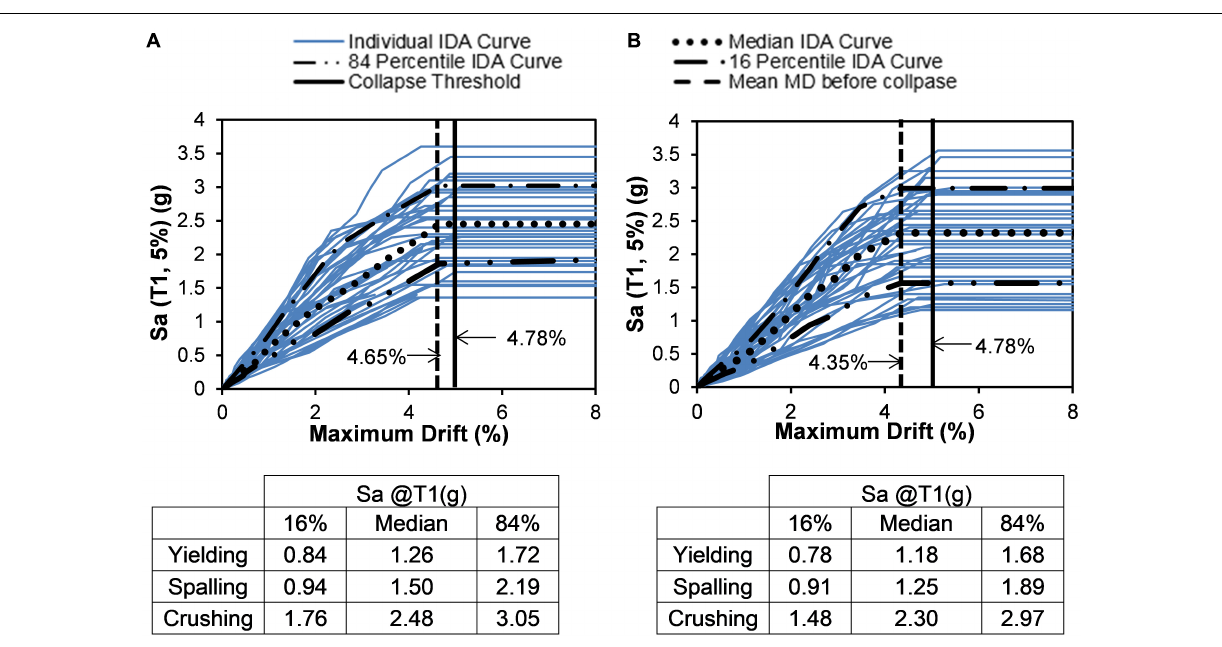
solid vertical lines in the figures. These figures also show the mean collapse residual drift of each bridge bent (dashed vertical line) when subjected to long-duration motions. Figure 13 reveals that the SMA-B-T bent, reinforced with SMA in the top and bottom plastic hinge, could undergo large residual drift